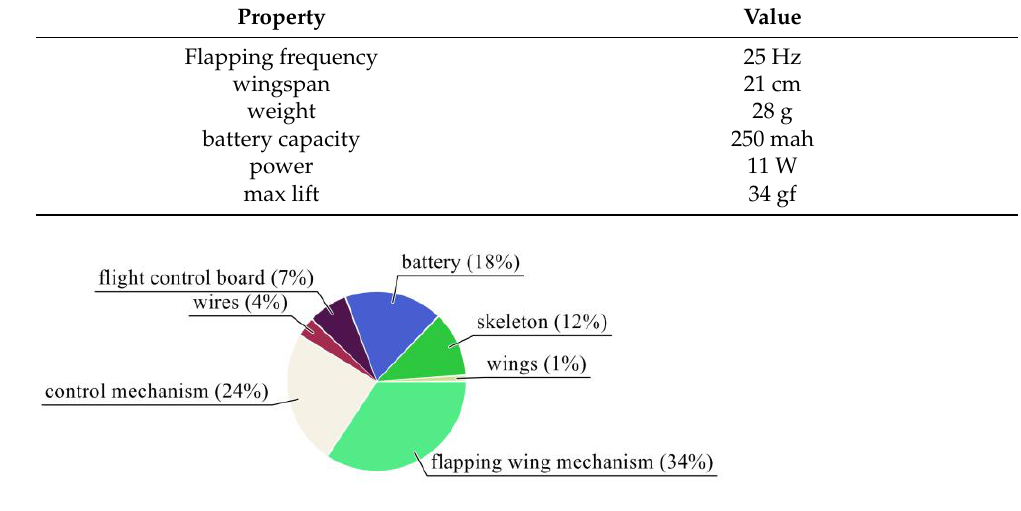
Figure 11. The mass distribution of the FMAV.